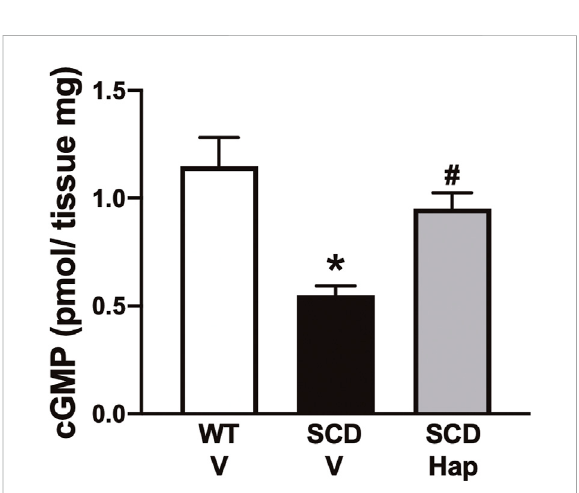
FIGURE 7 Basal GMP contents of penis from WT and SCD mice treated or not with haptoglobin. Data represent the mean ± S.E.M. for 6 mice in each group. * p < 0.05 vs. WT-Vehicle; # p < 0.05 vs.